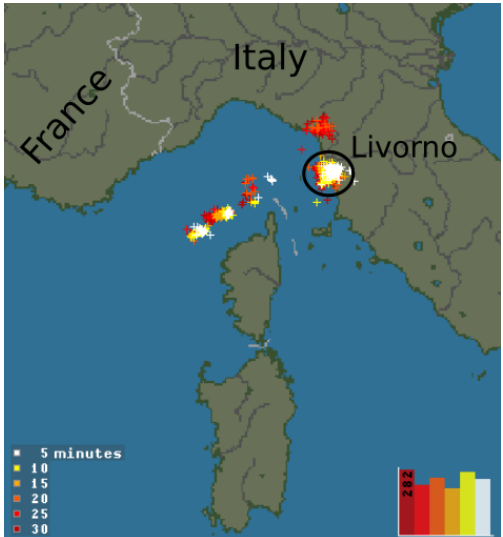
Figure 19. Strikes recorded on 4 October 2015, from 05:00 to 05:30UTC, by means of the Blitzortung network for lightning and thunderstorms, retrieved through the online archive. (courtesy of Blitzortung.org)